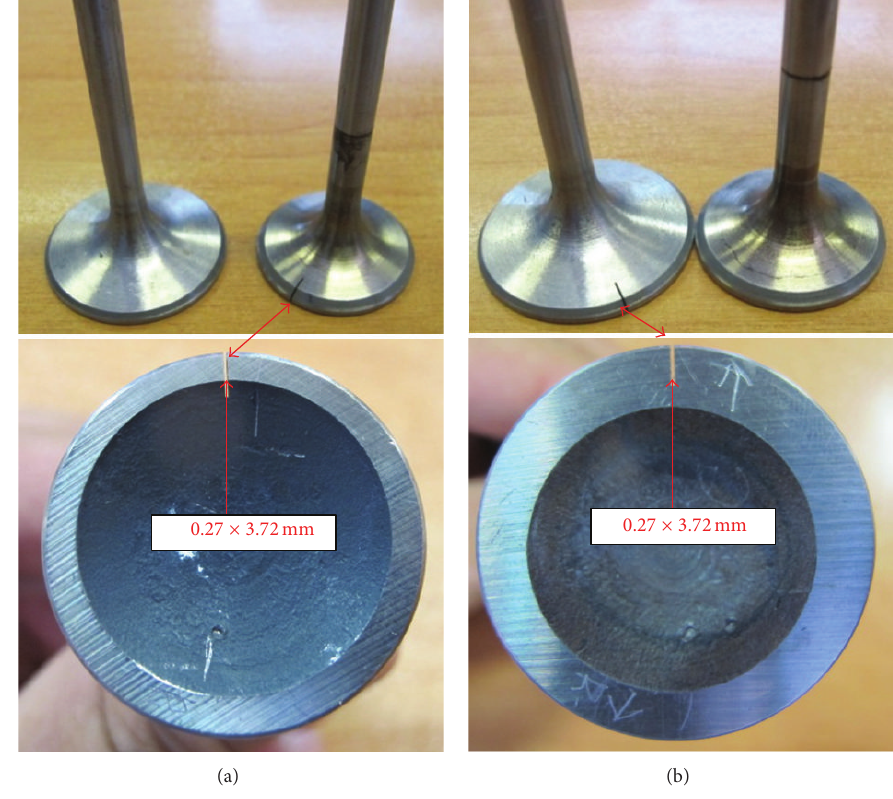
Figure 2: Semicracked valves. (a) Cylinder number 1 and (b) cylinder nymber 2.